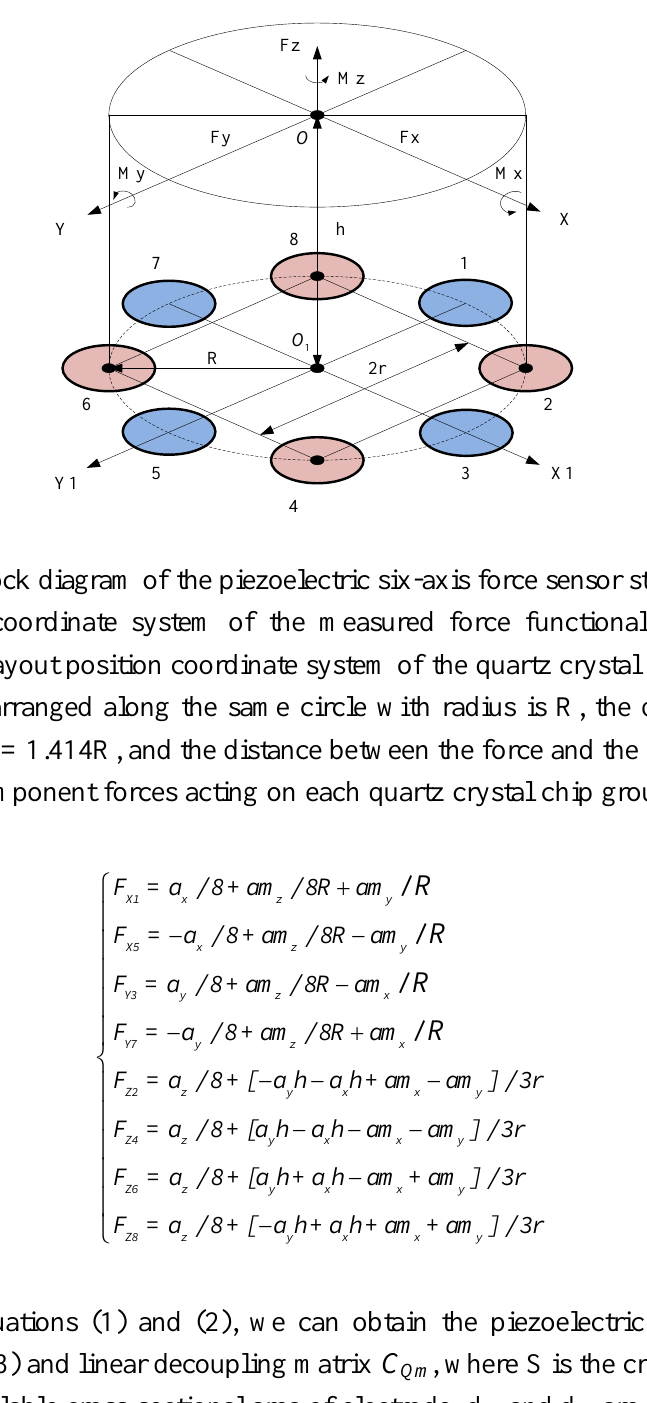
Figure 2. Block diagram of the sensor’s